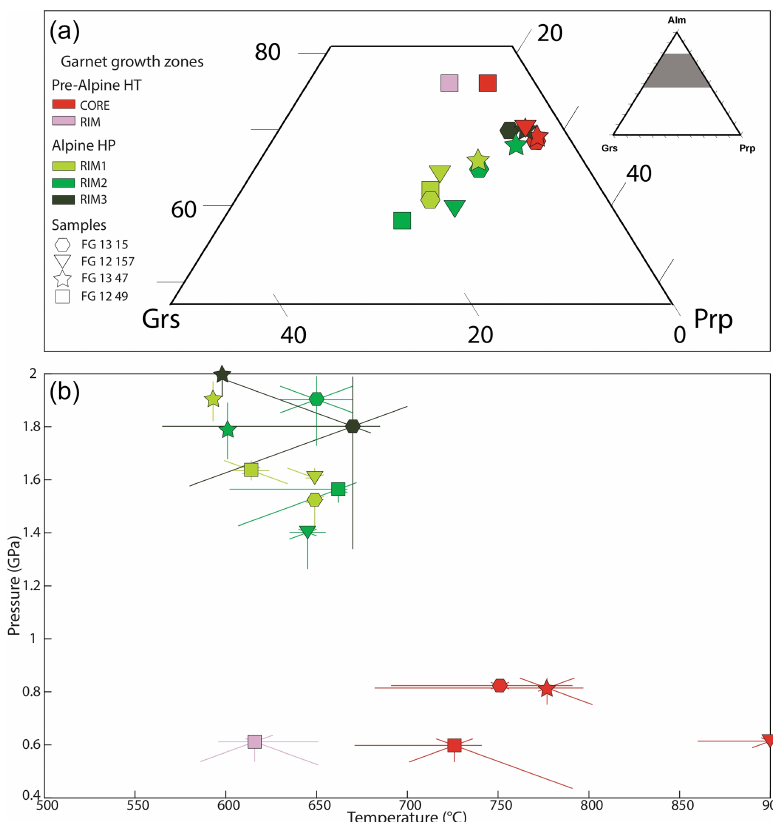
Figure 9. (a) Endmember diagram of the garnet growth zones from the four mica schists. (b) P – T diagram with a summary of the modelled conditions for each garnet growth zone. Note the major difference in P – T conditions from the pre-Alpine to the Alpine generations. The effect of uncertainties in each set of isopleths is shown around the P – T model of each growth zone (dataset from Lanari et al., 2017, and Giuntoli et al., 2018). For sample FG1249 the pre-Alpine rim (pink) corresponds to Rim1, Rim1 to Rim2, and Rim2 to Rim3 in the